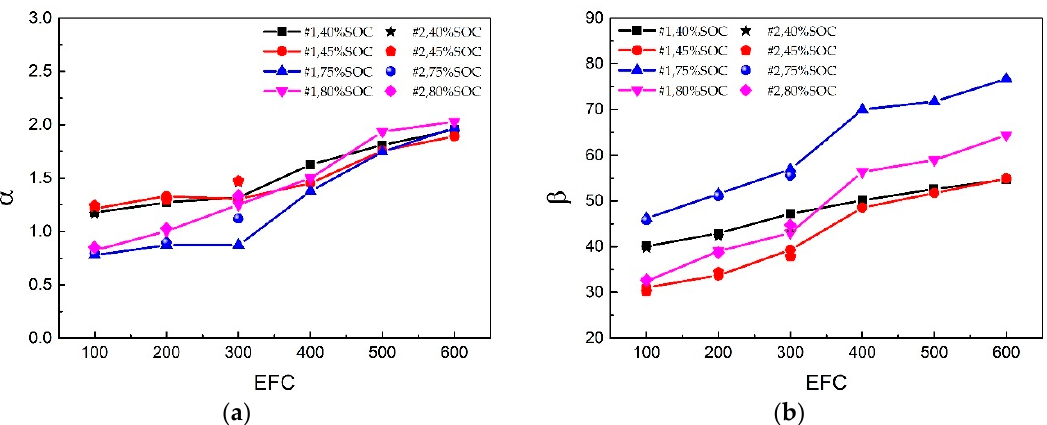
Figure 10. Relationship between relaxation voltage model parameters and aging cycles at 40%, 45%, 75%, and 80% SOC under discharging condition of cell #1. ( a ) results of α ; ( b ) results of β .